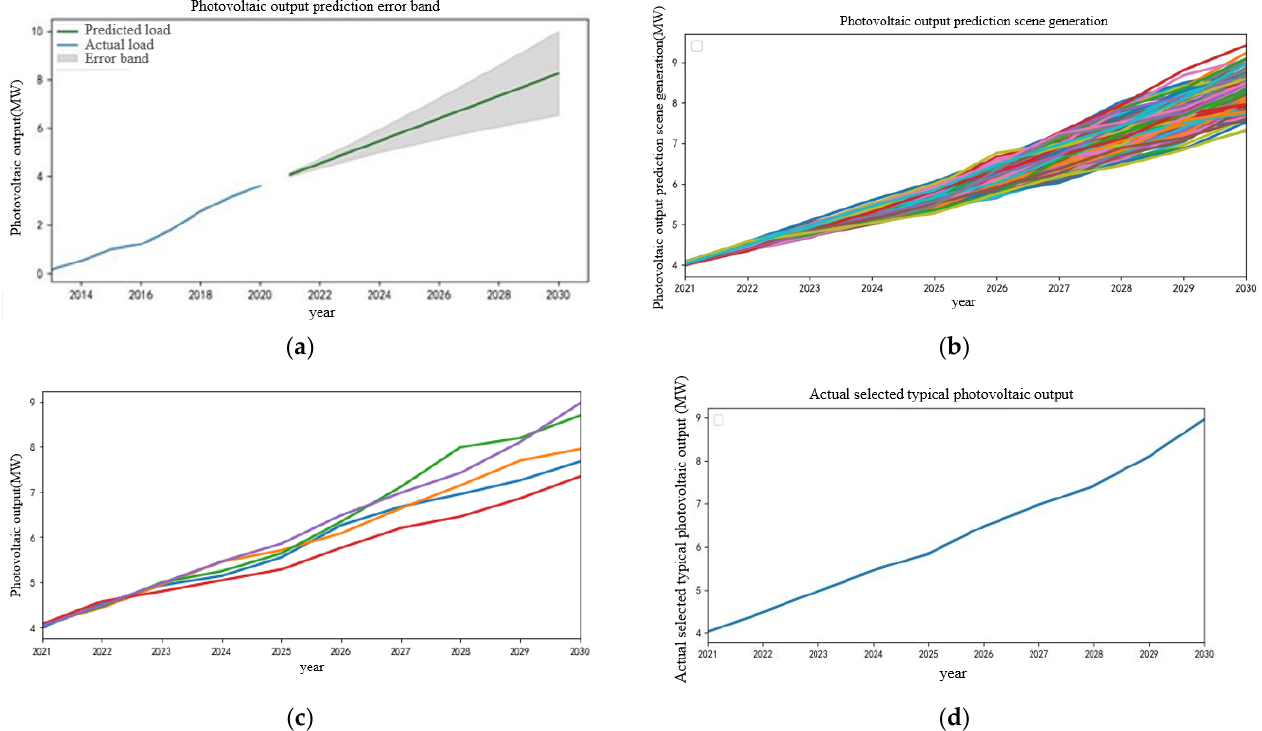
Figure 9. Photovoltaic output prediction results. ( a ) Photovoltaic output prediction error band. ( b ) Photovoltaic output prediction scenario generation. ( c ) Photovoltaic output scenarios for the next 10 years after reduction. ( d ) Actual selected photovoltaic output